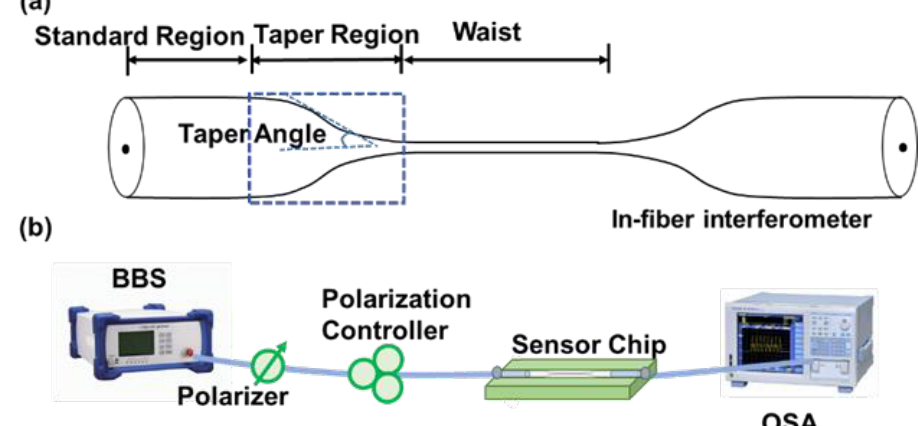
Figure 5. ( a ) Schematic of in-fiber interferometric structure. ( b ) Typical experimental setup of an in-fiber interferometer.